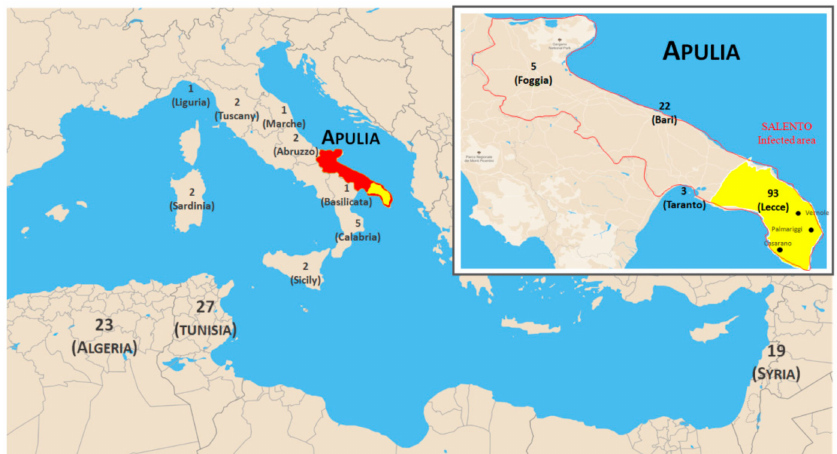
Figure 1. A geographic map of the Mediterranean basin and a zoom of the Apulia region in southern Italy. The numbers indicate the number of accessions sampled in individual Mediterranean countries, in Italian regions and in Apulian provinces. The yellow area highlights the zone of Salento a ff ected by the bacterium X. fastidiosa subsp. pauca . Three localities (Casarano, Palmariggi and Vernole) are finally reported in which five genotypes asymptomatic to the olive quick decline syndrome (OQDS) disease were